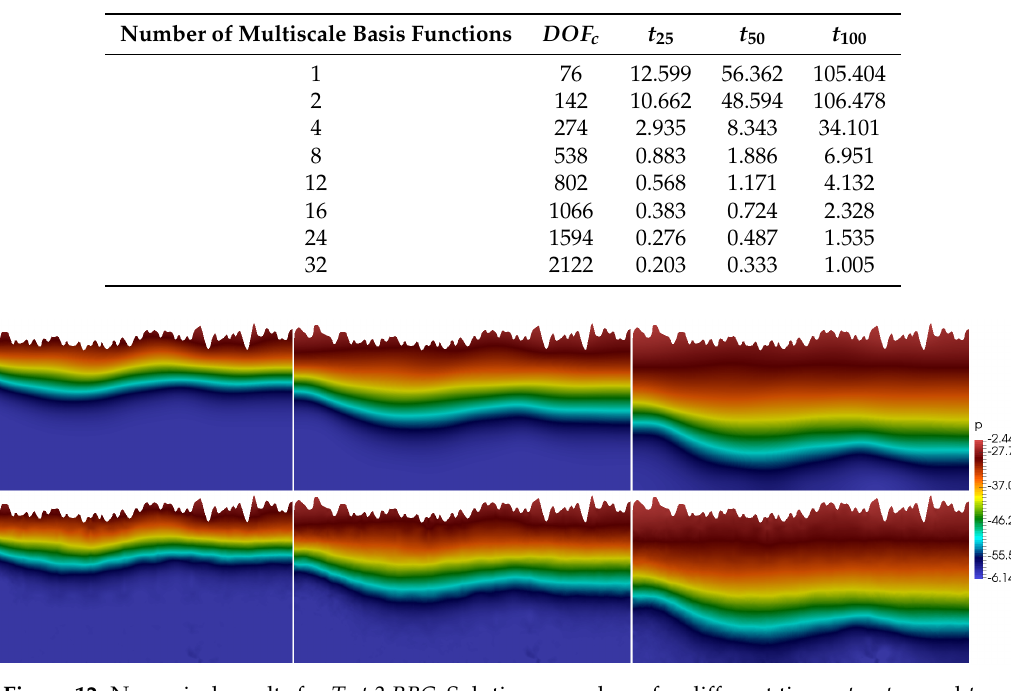
Figure 12. Numerical results for Test 2.RBC . Solutions p and p ms for different times: t 25 , t 50 , and t 100 (from left to right). First row: Fine-scale solution DOF f = 13,760. Second row: Multiscale solution using 16 basis functions DOF c = 1066. Table 6. Numerical results for Test 2.RBC . Relative L 2 error (%) for different numbers of multiscale basis